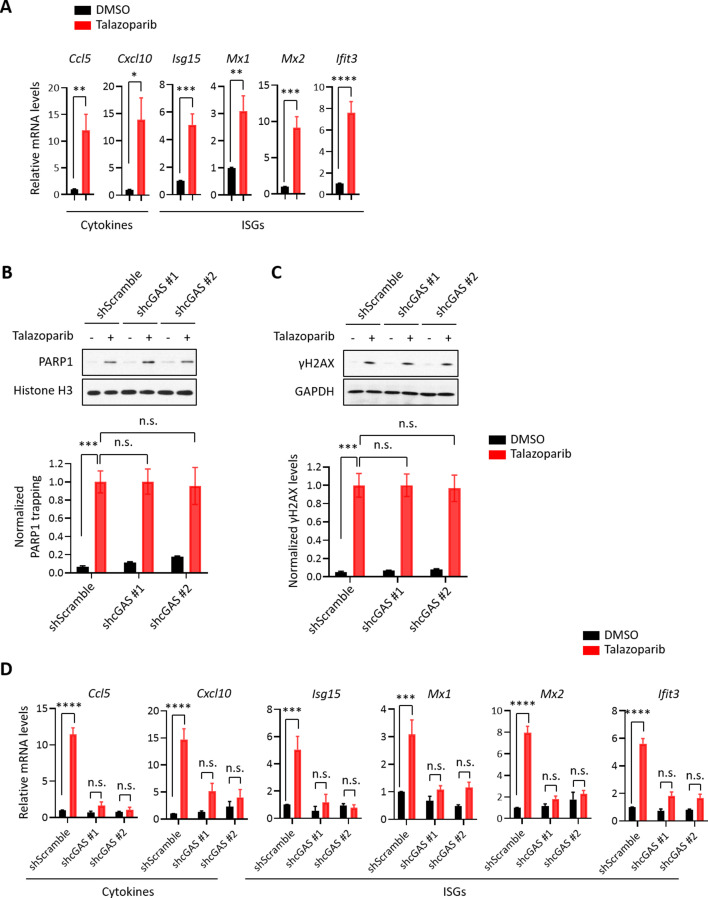
Proteomic profiling of PARPi-induced innate immune response (Part 1).(A) RT-qPCR analyses of cGAS-STING target gene expression in HeLa cells treated with or without Talazoparib (10 µM for 72 hr). Values of cytokines and ISGs mRNA levels were presented as means ± SEM from three biological replicates. Significance was determined with unpaired Student’s t-test. *p < 0.05, **p < 0.01, ***p < 0.001, ****p < 0.0001. (B) The levels of trapped PARP1 in HeLa cells expressing shRNA against control (shScramble) or cGAS (shcGAS #1 or #2) that were treated with or without Talazoparib (10 µM for 72 hr). Top, chromatin-bound fractions were isolated and were probed using the indicated antibodies. Histone H3 was used as the loading control. Bottom, the graph shows the quantification of the levels of PARP1 trapping. Values were presented as means ± SD from three biological replicates. Significance was determined with two-way ANOVA. ***p < 0.001, n.s., not significant. (C) The extent of DNA damage in HeLa cells expressing shRNA against control (shScramble) or cGAS (shcGAS #1 or #2) that were treated with or without Talazoparib (10 µM for 72 hr). Top, whole cell lysates were probed using the indicated antibodies. Bottom, the graph shows the quantification of γH2AX levels. Values were presented as means ± SD from three biological replicates. Significance was determined with two-way ANOVA. ***p < 0.001, n.s., not significant. (D) RT-qPCR analyses of cGAS-STING target gene expression in HeLa cells expressing shRNA against control (shScramble) or cGAS (shcGAS #1 or #2) that were treated with or without Talazoparib (10 µM for 72 hr). Values of cytokines and ISGs mRNA levels were presented as means ± SEM from three biological replicates. Significance was determined with two-way ANOVA. ***p < 0.001, ****p < 0.0001, n.s., not significant.